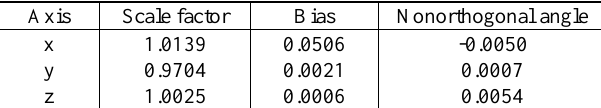
Table 2. Calibrated parameters of the gyroscope triad